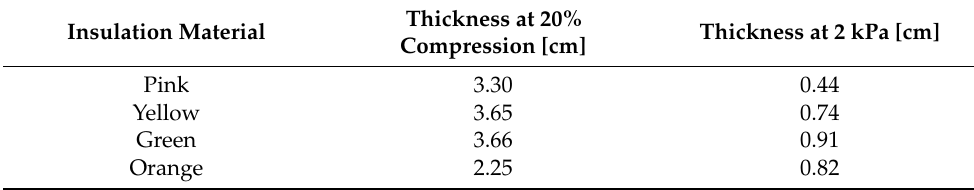
Table 4. Thicknesses during the thermal conductivity measurements.